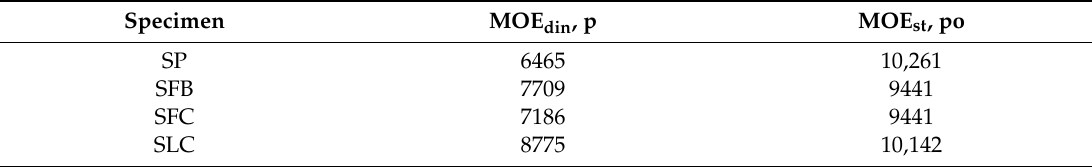
Table 1. Mechanical properties of pine elements and poplar planks used for the